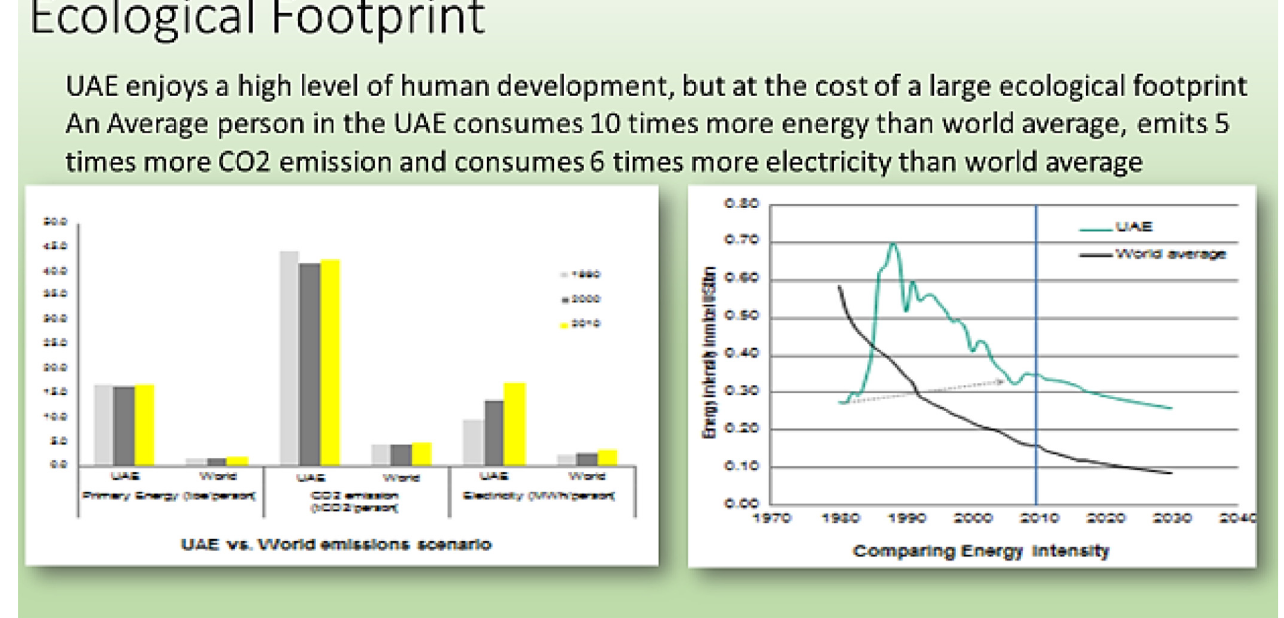
Fig. 8. UAE ecological footprint.